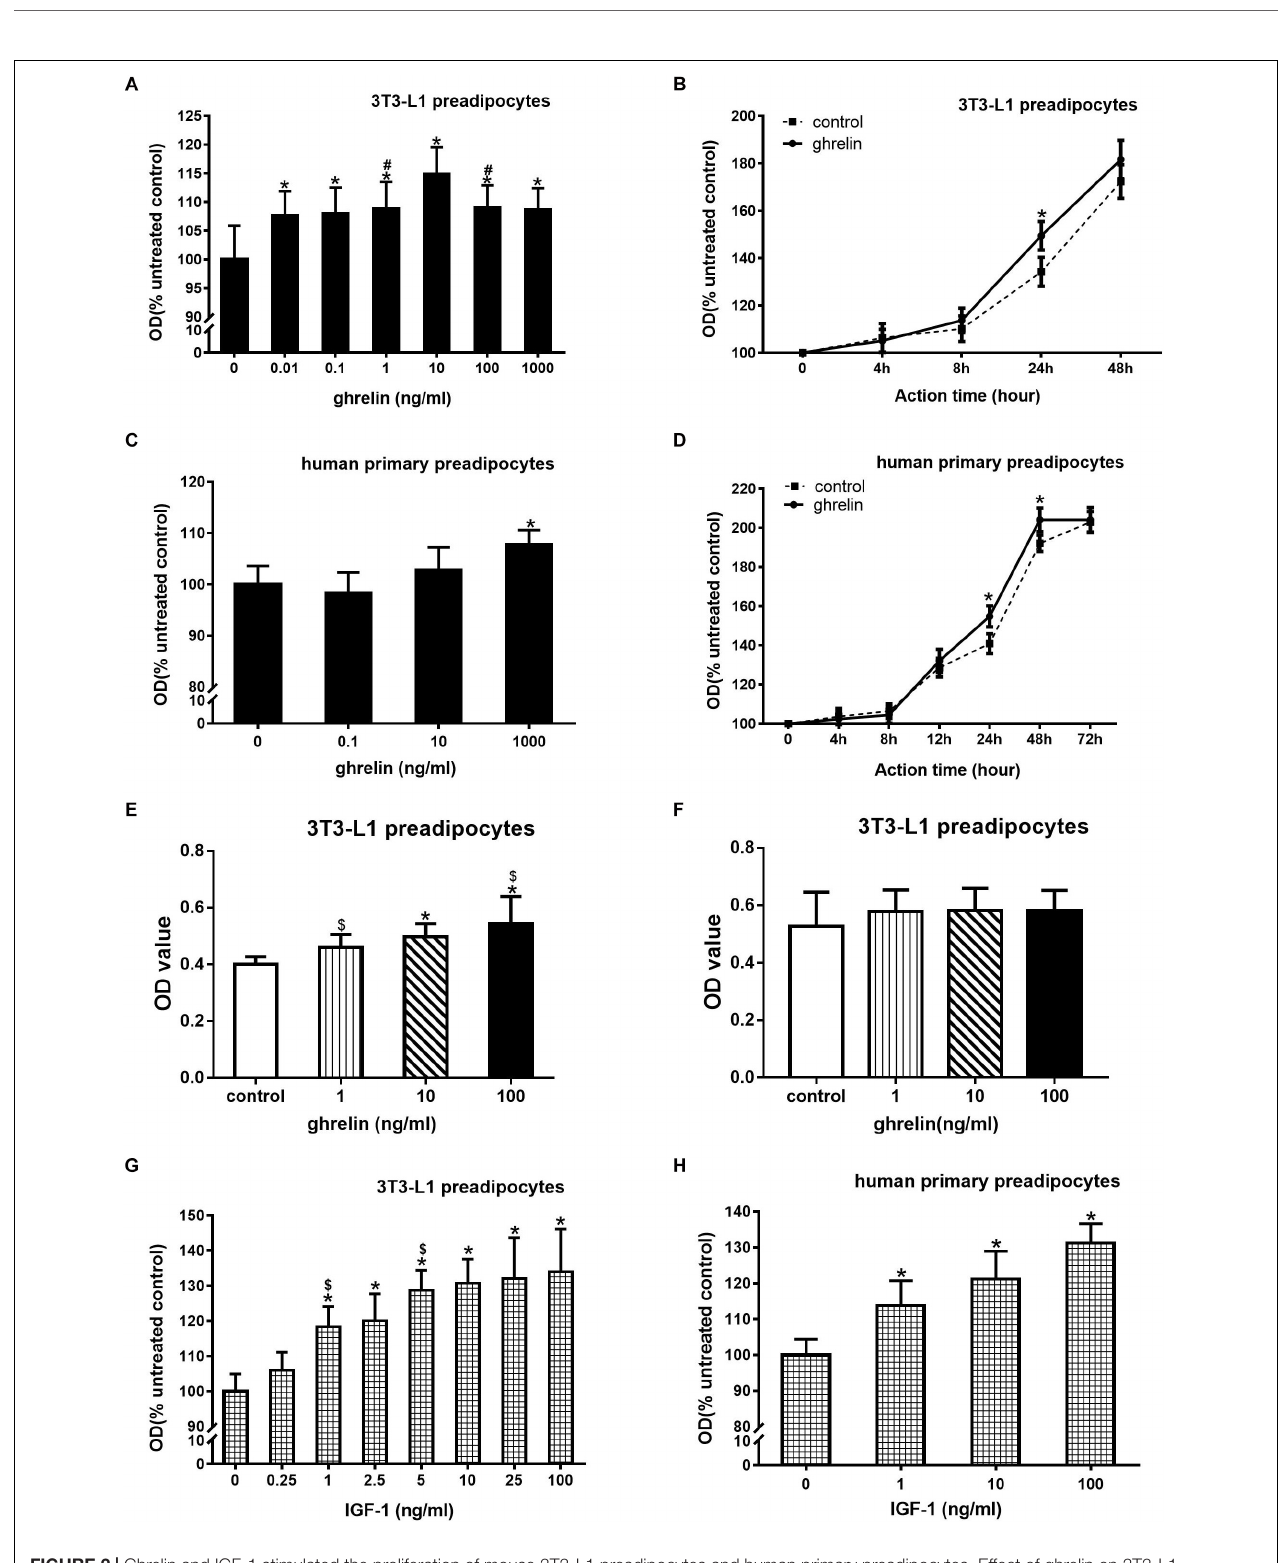
FIGURE 2 | Ghrelin and IGF-1 stimulated the proliferation of mouse 3T3-L1 preadipocytes and human primary preadipocytes. Effect of ghrelin on 3T3-L1 preadipocytes at indicated concentrations (A) and time (B) . Effect of ghrelin on human primary preadipocytes at indicated concentrations (C) and time (D) . CCK-8 measurement of 3T3-L1 preadipocytes for 24 h (E) or 48 h (F) . Effect of ghrelin on 3T3-L1 preadipocytes at indicated concentrations (G) and time (H) . The data are presented as the mean ± SD for six (A,C,G,H) or three (B,D,E,F) independent experiments with eight individual wells in each experiment. ∗ p < 0.05 vs. control group, # p < 0.05 vs. 10 ng/ml ghrelin group, $ p < 0.05 in two groups.